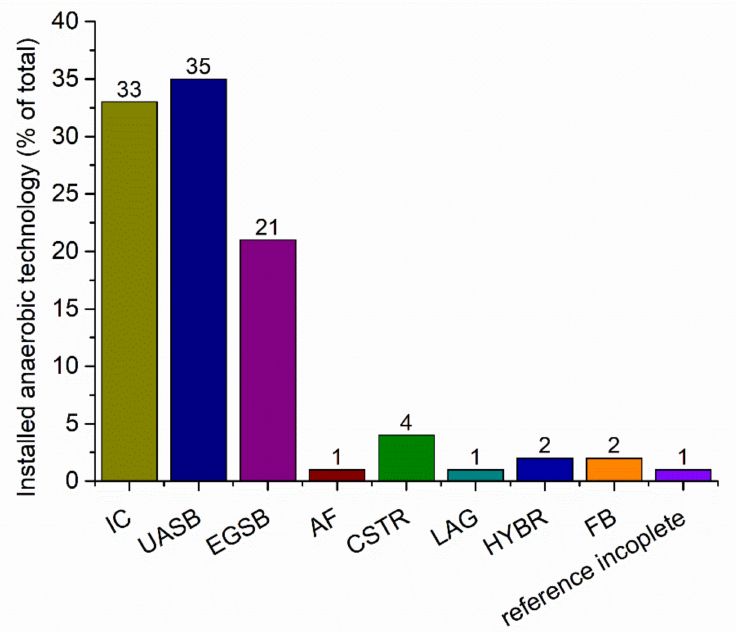
Figure 5. Implemented anaerobic technologies for industrial wastewater pictured for the period 2002–2019. IC: Internal Circulation; UASB: Upflow Anaerobic Sludge Blanket; EGSB: Expanded Granular Sludge Bed; AF: Anaerobic Filter; CSTR: Continuously Stirred Tank Reactor; LAG: anaerobic lagoon; HYBR: combined system with sludge bed at the bottom section and a filter in top; FB: fluidized bed reactor; adopted from [36], updated and edited by